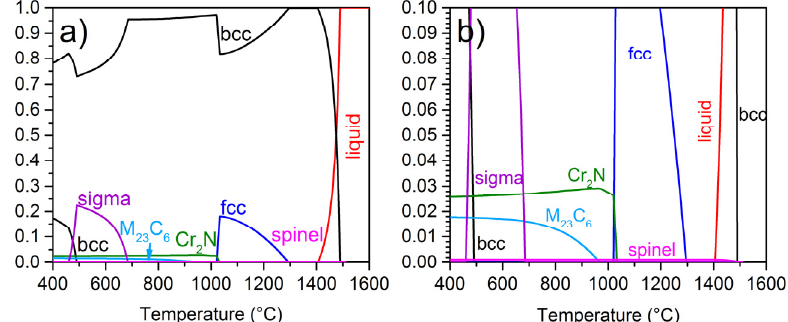
Figure 2. Phase fraction diagram for the SS446 ferritic stainless steel, where ( a ) shows the full phase composition and ( b ) a magnified diagram showing phases with a mole fraction of up to 0.1.